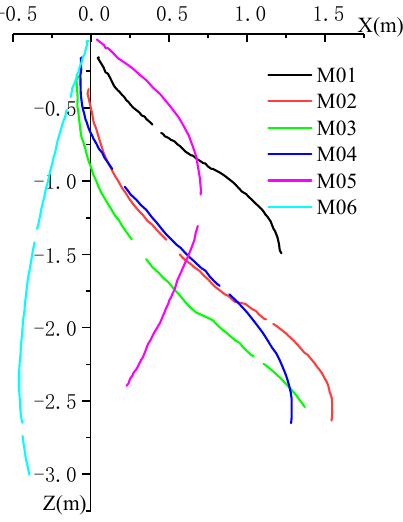
Figure 9. The X–Z profile movement trajectory at the monitoring points.